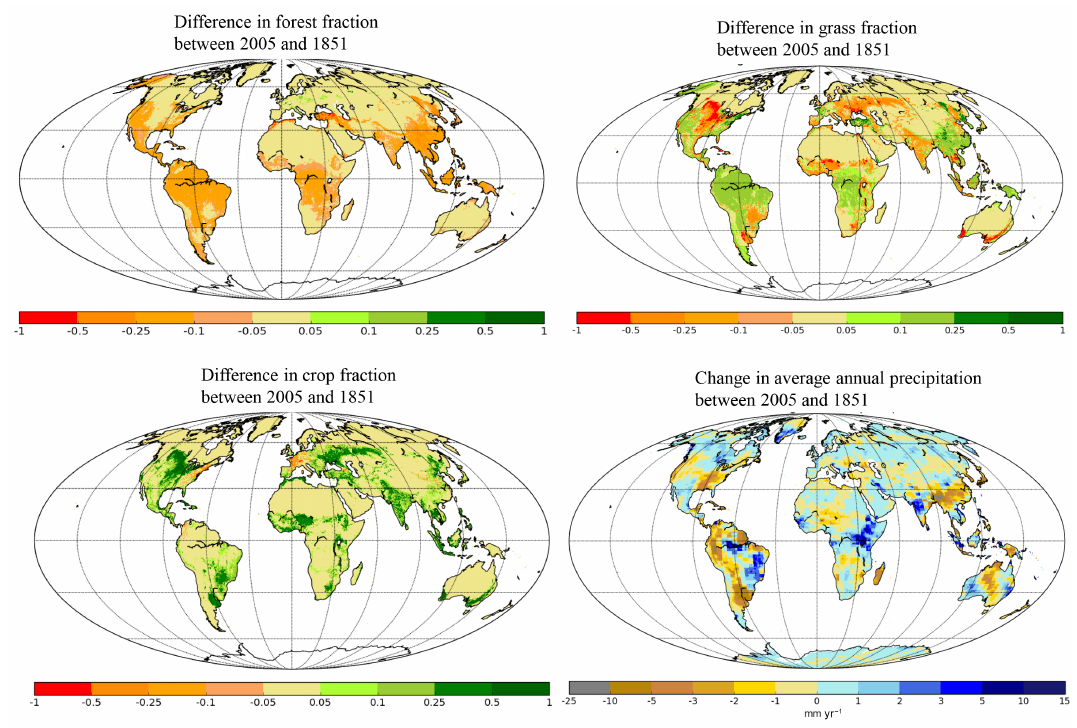
Figure 2. Spatial patterns of the difference in forest, crop, and grassland area between 1851 and 2005 represented as a fraction of a grid cell. And spatial patterns of the change in average annual precipitation between 1851 and 2005 in mmyr − 1 , calculated as the total change in precipitation over the period 1850–2005 and divided by the number of years in this